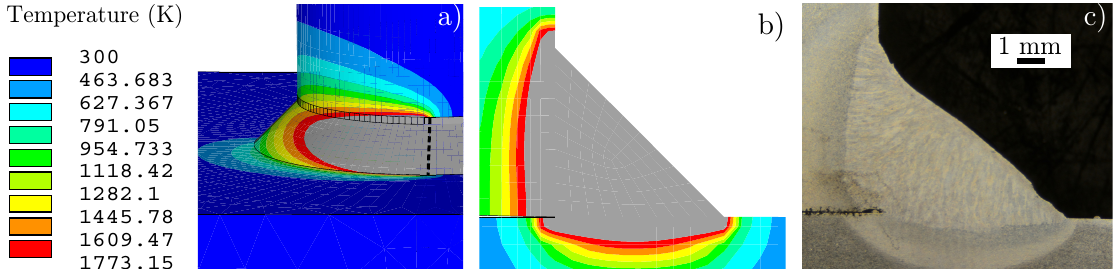
Figure 9. Constant initial temperature: Overview of the thermal solution ( a ), FE-model cross section of the weld seam ( b ), and real cross section of the weld seam ( c